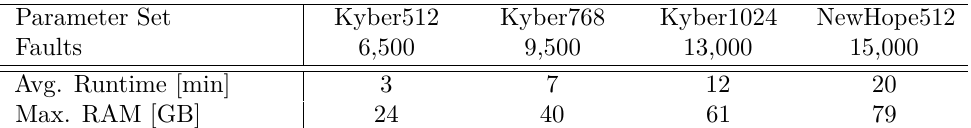
Table 1: Resource requirements for running the attack for one selected number of faults per parameter set. All measurements used 8 cores of a Xeon E5-4669 v4 2.2 GHz. Parameter